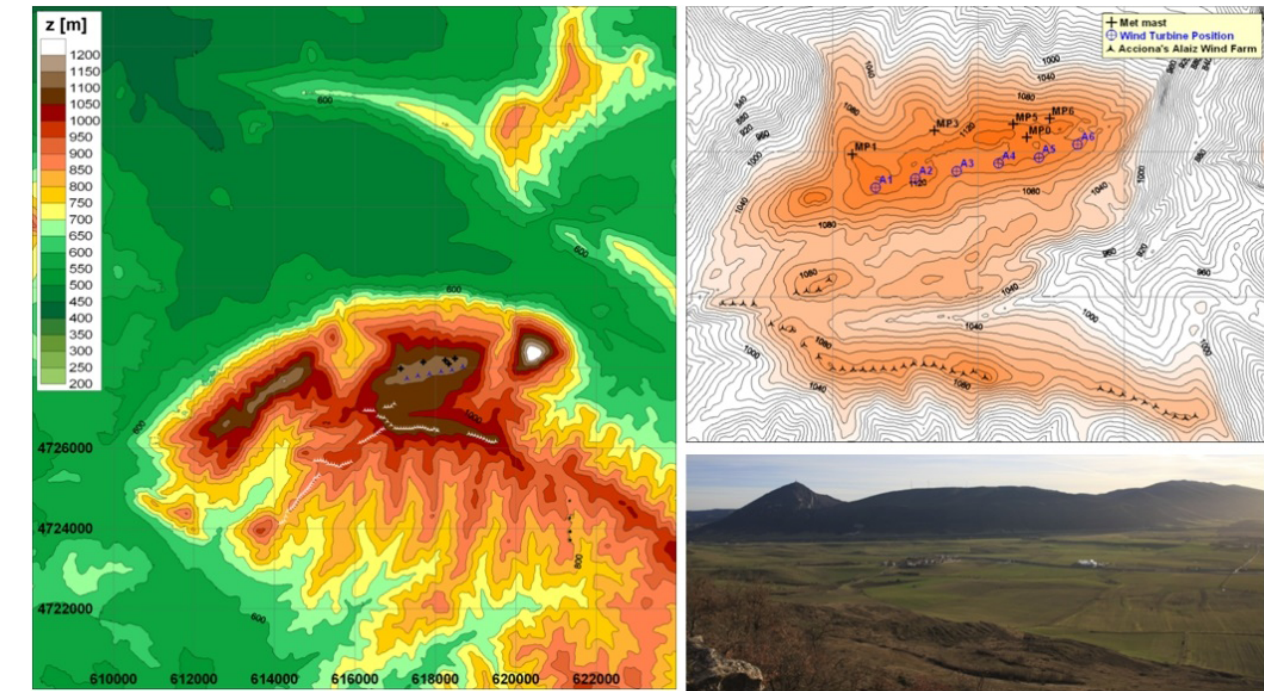
Figure 1. Alaiz elevation map, close-up of the test site and view from the upstream ridge to the north.